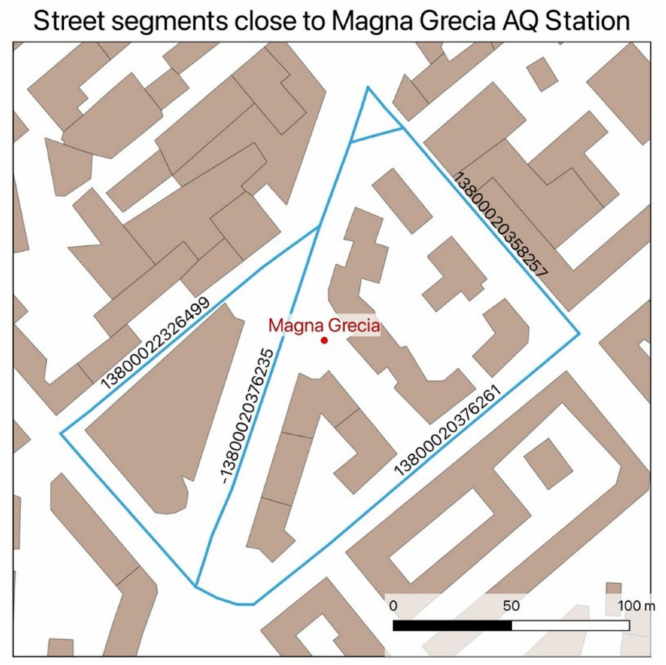
Figure 3. Street segments in proximity to the AQ Station Magna Grecia for which the time variability was studied. The labels indicate the ID number of the street segment within the database.